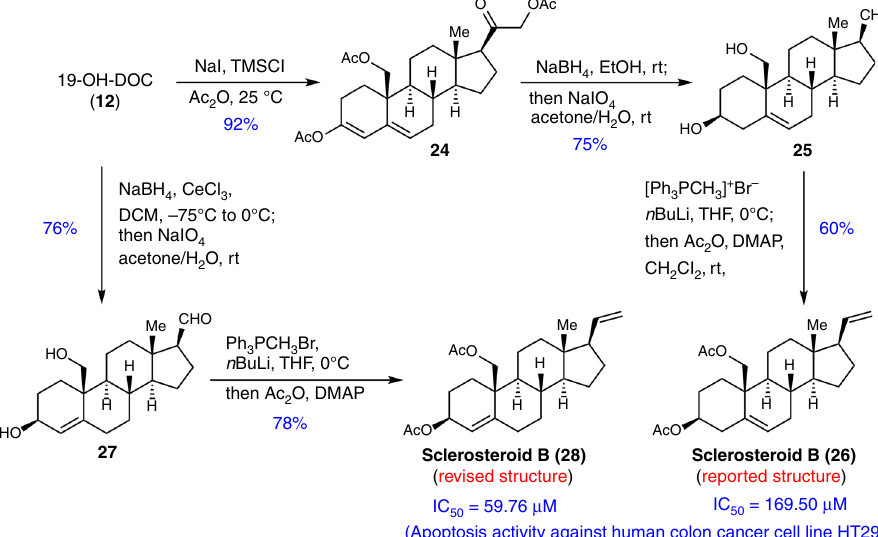
Fig. 5 Structure revision of sclerosteroid B based on synthesis. Both the proposed structure and corrected structure of sclerosteroid B were synthesized from 19-OH-DOC. In addition, their anticancer activities were